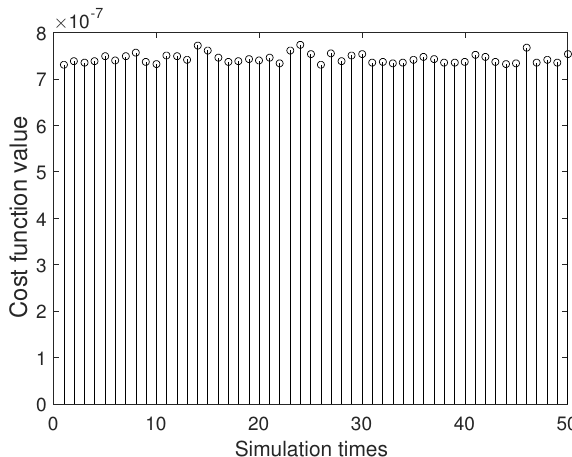
Figure 5. 50 simulation results of cost function for BSAS algorithm.